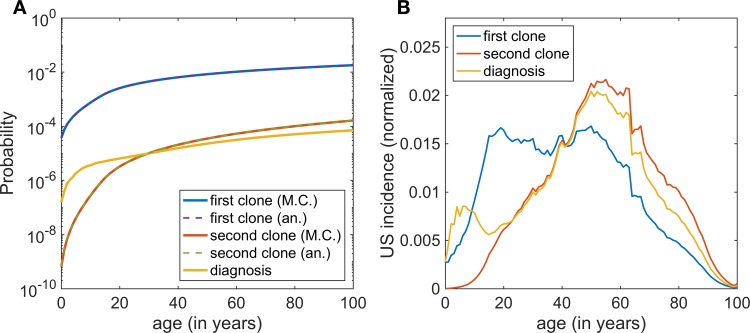
A. Likelihood of existence of clones over time. As a test of accuracy, the probabilities for the existence of the primary and secondary clones were also calculated analytically from a cumulative negative binomial distribution. Although the probability of harboring a clone is certainly non-negligible for most age groups, it is clear that the probability of diagnosis is many orders of magnitude smaller. B. The probability of obtaining a first or second clone in a given year as well as the probability of reaching the diagnosis threshold (20% of the HSC pool) folded with the 2010 US population distribution. The prevalence of every curve has been normalized to 1, so that these results may be interpreted as the age distribution of the clone and diagnosis arrival times. (M.C.: Markov Chain simulations; an.: Analytical calculations.)